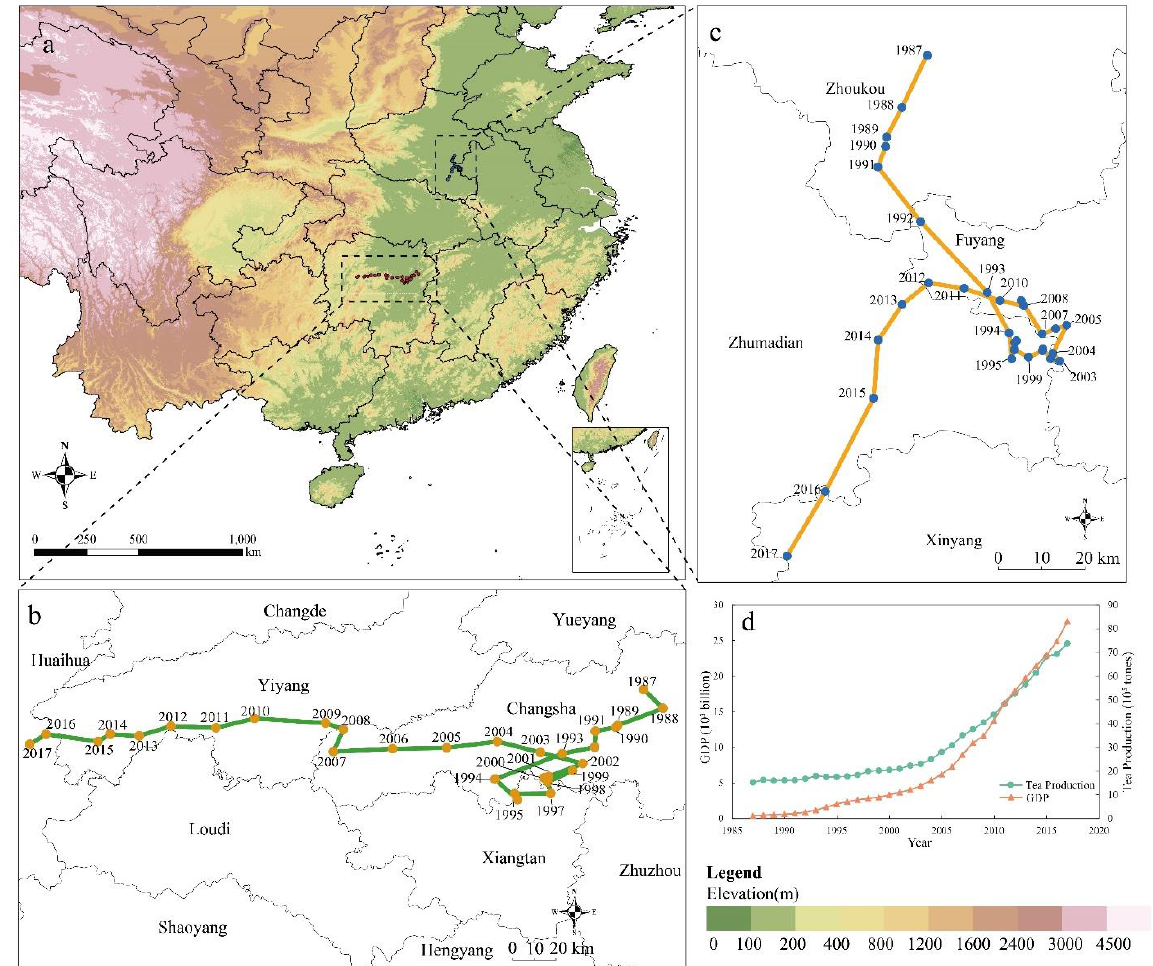
Figure 5. Movement of gravity center (COG) of tea production and economy from 1987 to 2017. ( a ) Trajectory location of tea production COG and GDP COG in China, ( b ) Trajectory of tea production COG, ( c ) trajectory of GDP COG, and ( d ) the Growth of tea production and GDP from 1987 to 2017.